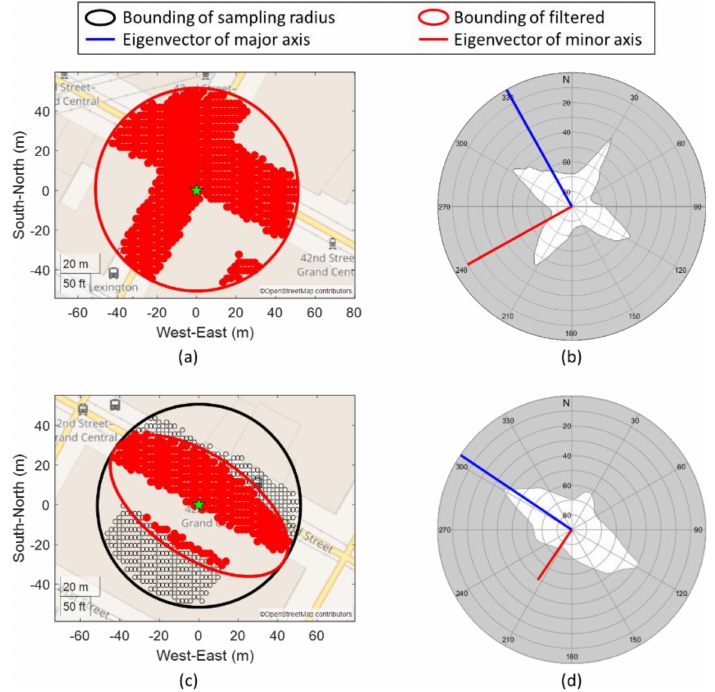
Figure 3. Typical cases of candidate sampling in urban environments on intersection ( a , b ) and straight street ( c , d ). Note that the eigenvectors (red and blue lines in ( b , d ) are projected back to azimuth and elevation angle (local frame) for illustration here.